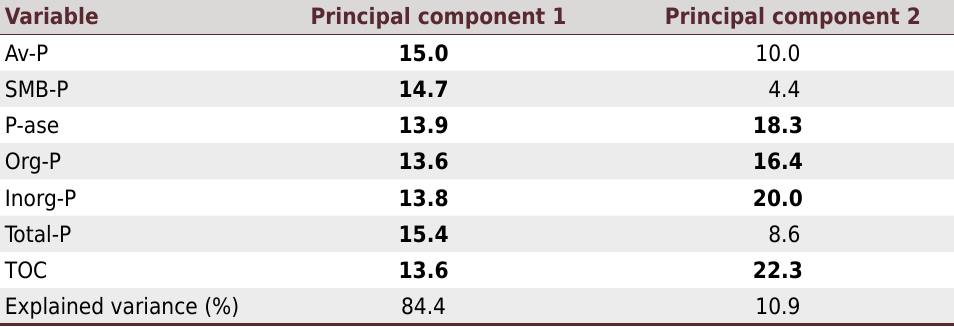
Table 6. Percentage explained by each principal component and percentage explained by each variable in each principal component. Bold numbers >|0.7|